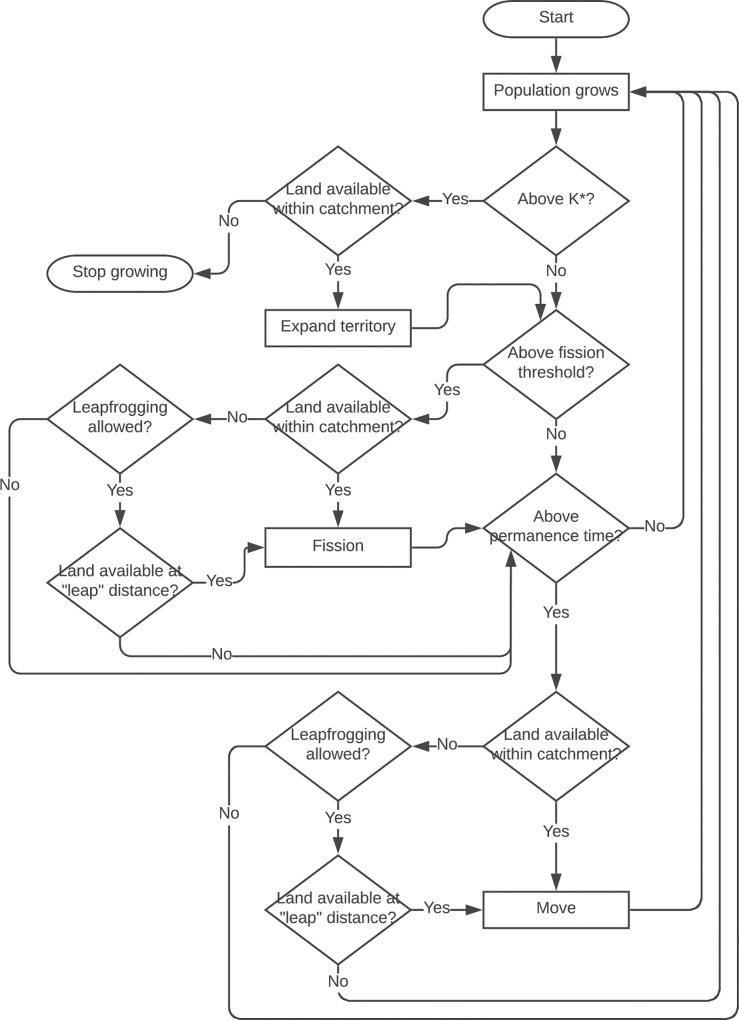
Model flowchart.